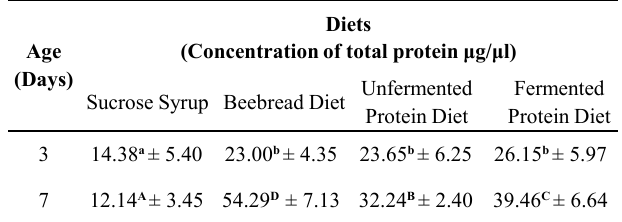
Table 1 . Mean and standard deviation of the concentration of total protein (μg/μl) in the hemolymph of honey bees confined in plastic cages at emergence, after feeding on beebread diet, sucrose syrup, unfermented protein diet or fermented protein diet for 3 - 7 days. Pools of hemolymph from 10 bees were analyzed from each of eight cages for each diet. Identical letters in the same row indicate the absence of significant statistical differences. Different letters in the same row indicate significant differences (ANOVA on Ranks and pair-wise comparisons were made using the Student-Newman-Keuls test and the t-test, p <